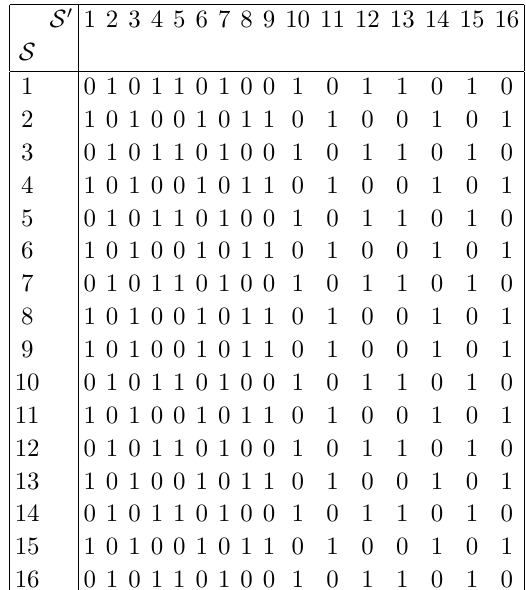
Table 18 . Gadget values for P